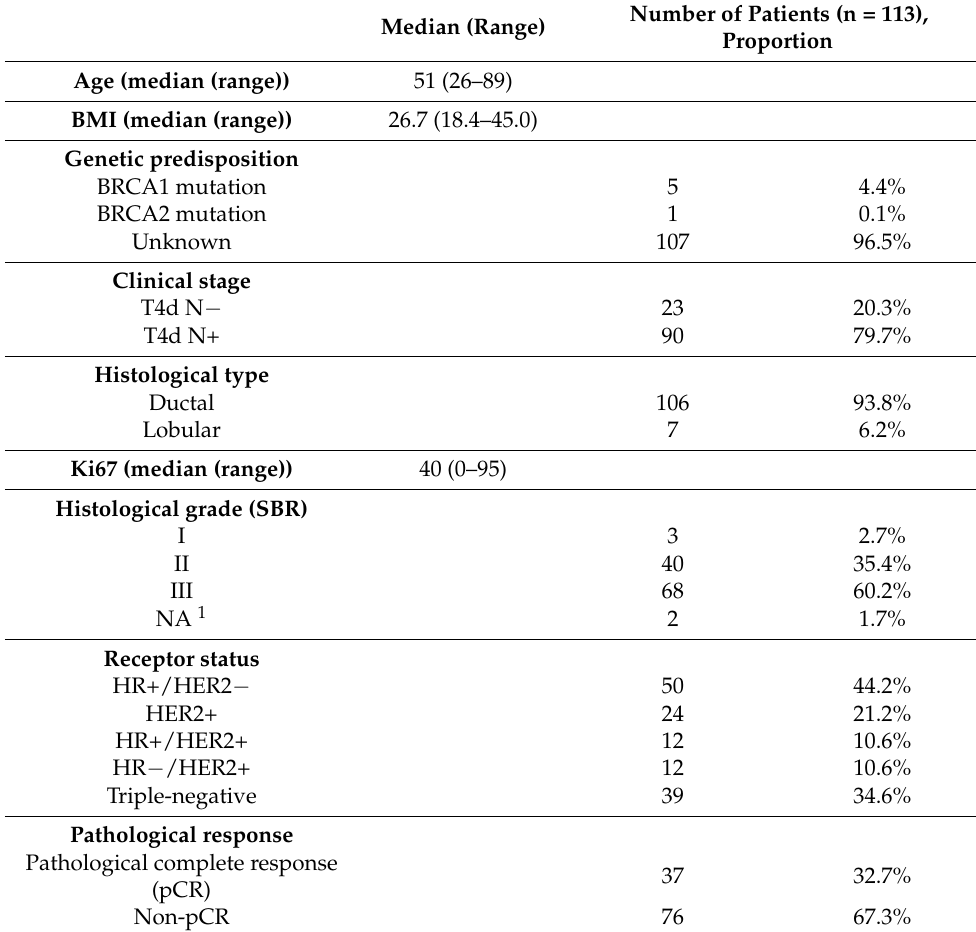
Table 1. Demographic